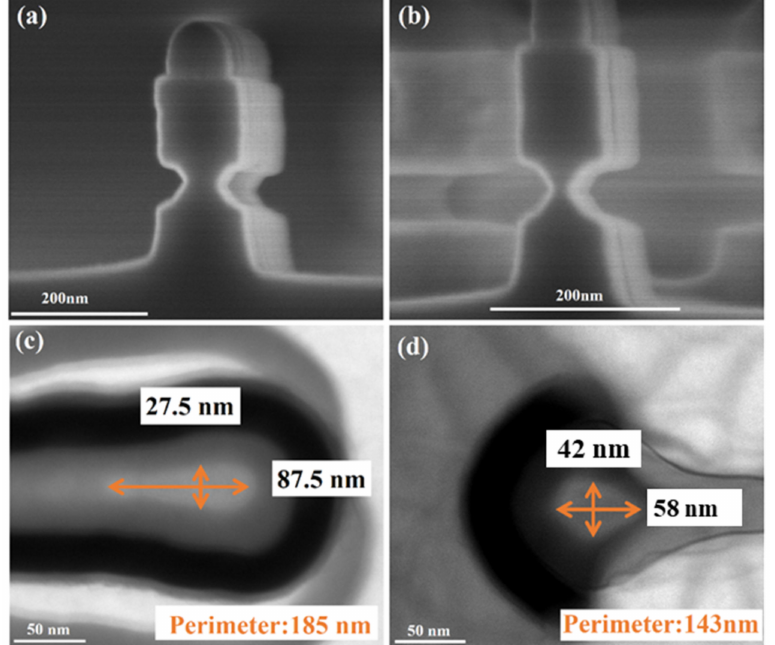
Figure 11. Cross-sectional SEM images of Ge selective etching with ALE, ( a ) 40 nm Ge channel with 15 cycles of ALE, and ( b ) 15 nm Ge channel with 20 cycles of ALE. Cross-sectional TEM top views of Ge VSAFETs: ( c ) NS with perimeter 185 nm, ( d ) NW with a square cross-section with perimeter 143 nm. Oxidation time t ox = 30 s and temperature of HNO 3 = 20 ◦